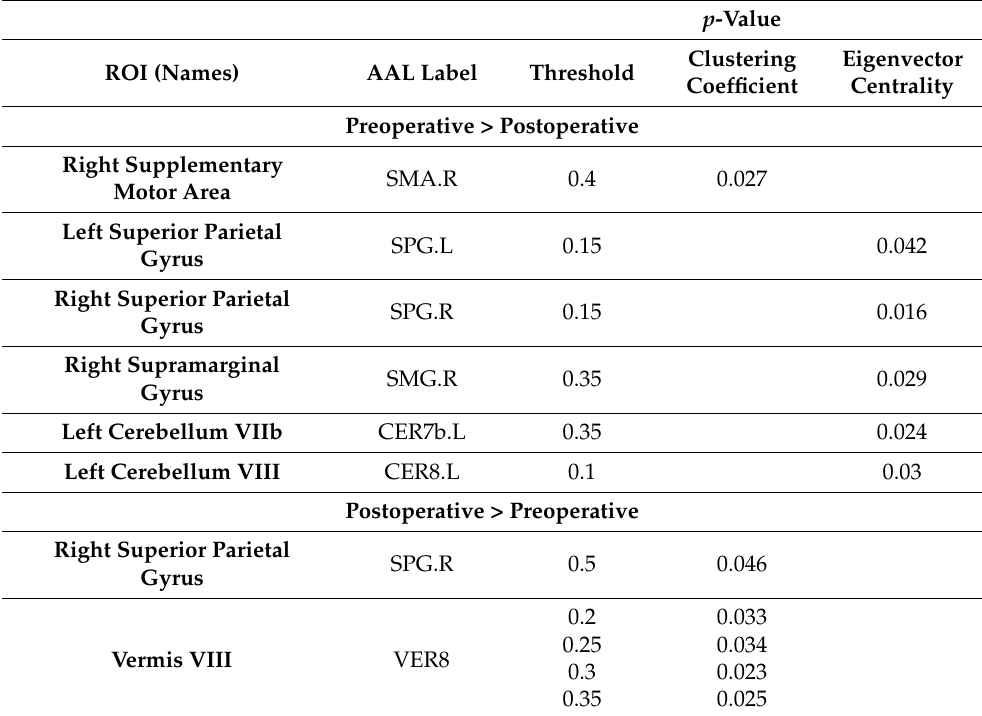
Table 2. List of brain ROIs with significant between-session differences in clustering coefficient and eigenvector centrality values, which correlate with ESS, SHAPS and PANAS values.